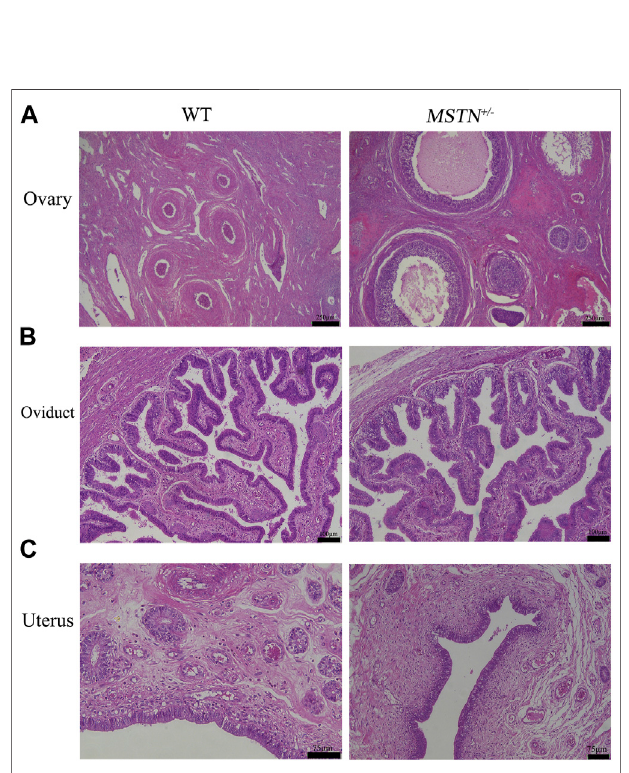
FIGURE 5 | Histological analysis of ovary, oviduct and uterus in 8- month-old MSTN +/ − and WT sow. (A – C) Ovarian (A) , tubal (B) , and uterine (C) histology image from WT (left) and MSTN +/ − (right) sow.